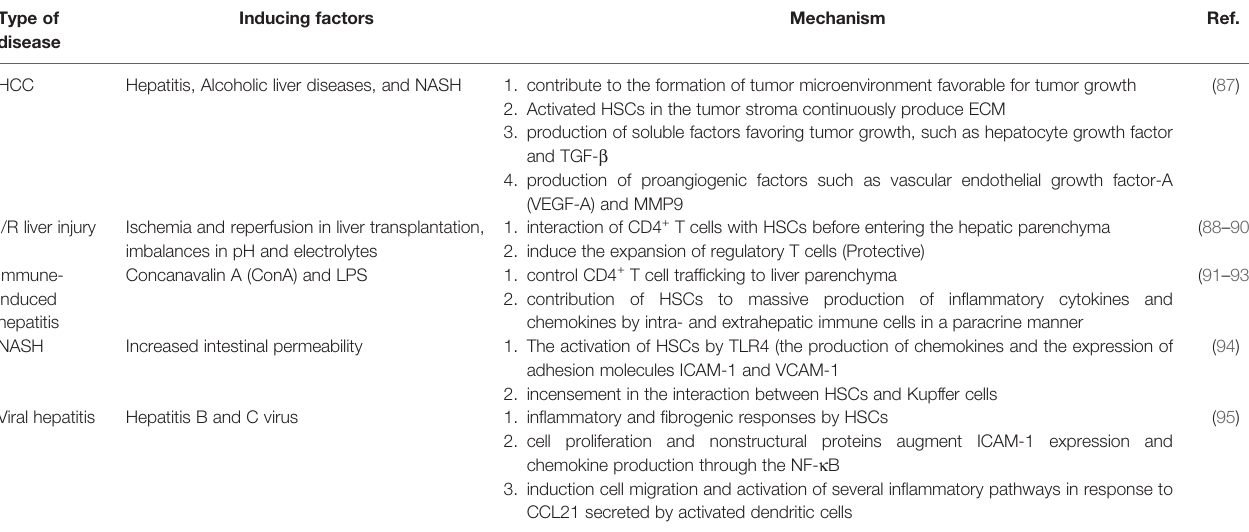
TABLE 2 | Hepatic satellite cells role in different liver